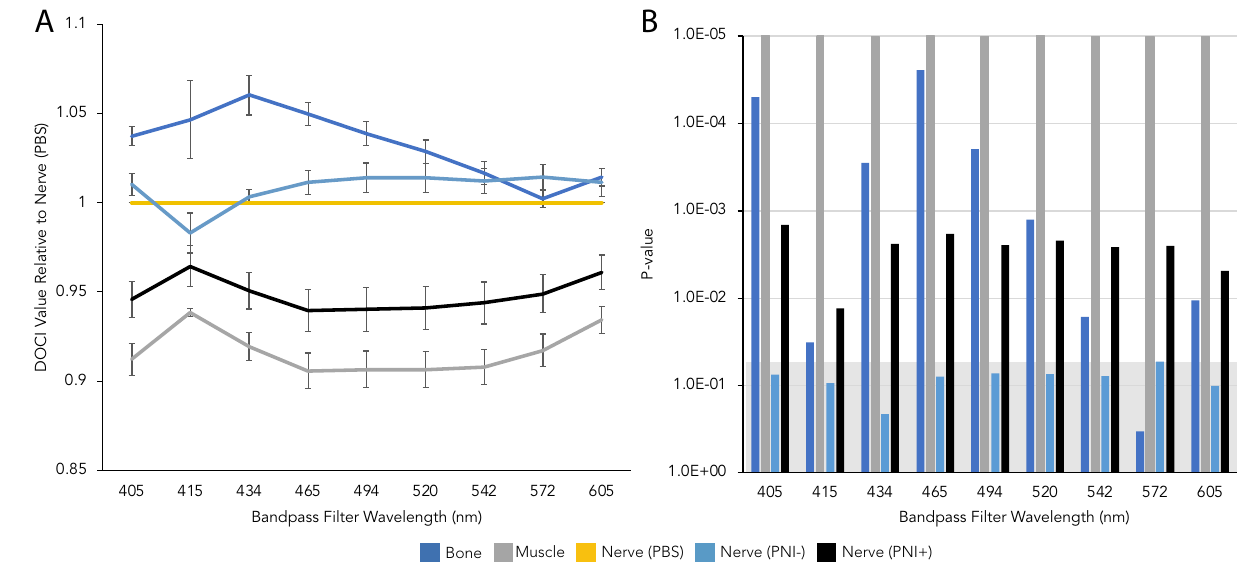
Figure 4. Relative lifetimes of PNI compared to healthy tissue. ( A ) Average relative lifetimes (DOCI values) of different tissue types as a function of wavelength (n = 6). PNI− nerve refers to normal nerve adjacent to tumor. ( B ) Manhattan plot of P values for DOCI values of each tissue type compared to PNI+ nerve across all wavelengths. Significance is defined as P < 0.05. The significance threshold is denoted in gray and all bars above the threshold are considered